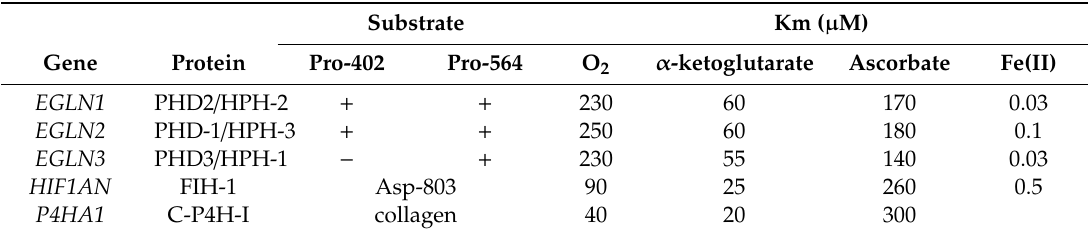
Table 1. Enzymatic properties of HIF- α hydroxylases and type I collagen hydroxylase. Substrate Km ( µ M) Gene Protein Pro-402 Pro-564 O